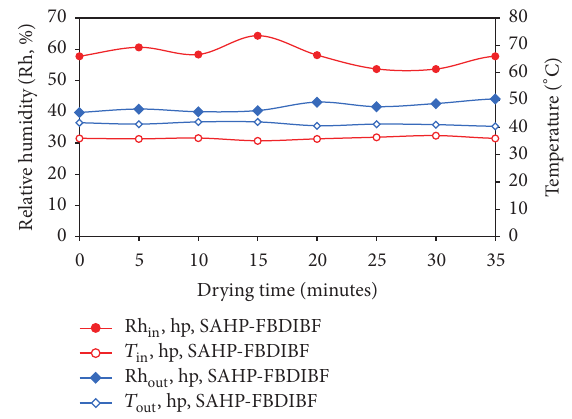
Figure 10: The variation of air temperature and relative humidity with drying time for SAHP-FBDIBF.